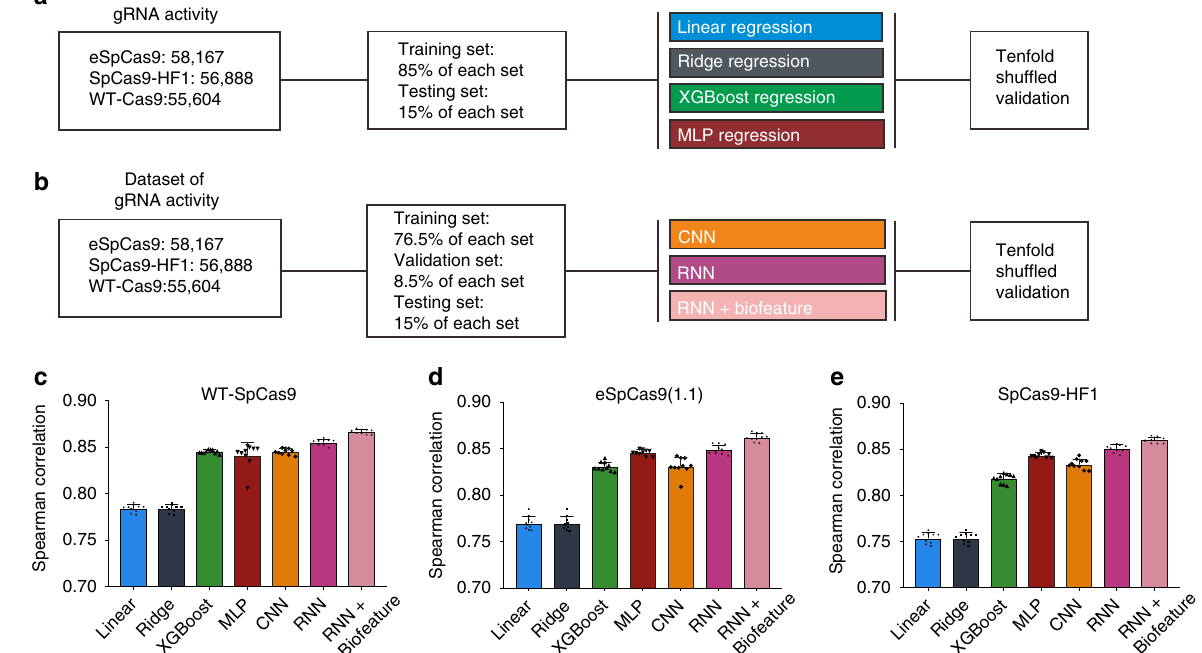
Fig. 5 Performance of different algorithms for gRNA activity prediction. a Schematic of data set and conventional algorithms. Four conventional algorithms including linear regression, ridge regression, XGBoost regression, and MLP were constructed, respectively. In all, 85% of the relevant data set was used as the training set, and the reserved 15% of the data set in each set as the test set to measure the generalization ability of each model to predict unseen data. b Schematic of the data set and deep-learning algorithms. Deep-learning algorithms including CNN, RNN, and RNN + biofeature were constructed, respectively. In total, 76.5% of the relevant data set was used as the training set, 8.5% of the data set in each set was used as the validation set, and the reserved 15% of the data set in each set was used as the test set to measure the generalization ability of each model to predict unseen data. c – e Performance of different algorithms for gRNA activity prediction revealed by Spearman correlation for WT-SpCas9, eSpCas9(1.1), and SpCas9-HF1, respectively. The bar plot shows the mean ± s.d. for the Spearman correlation coef fi cient between predicted and measured gRNA activity scores ( n =